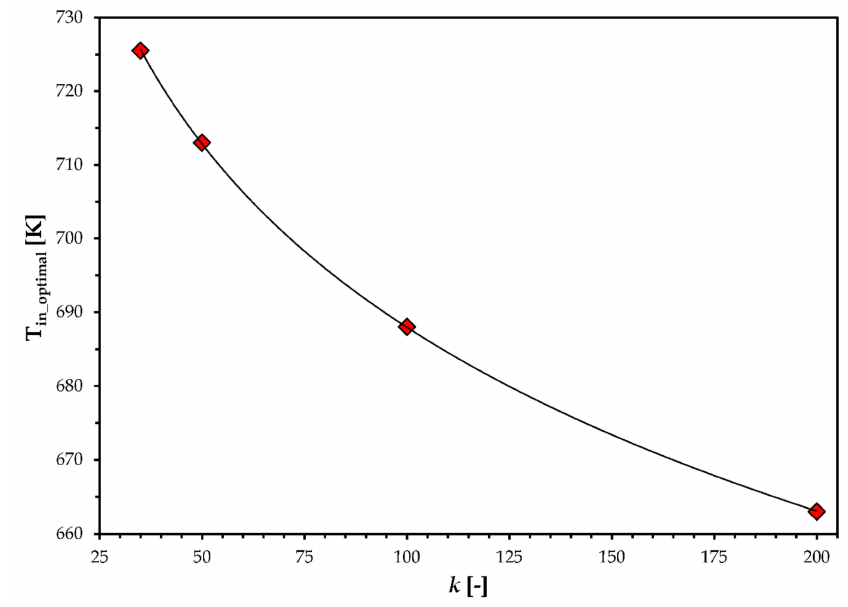
Figure 13. Optimal inlet gas temperature, T in_optimal , versus k